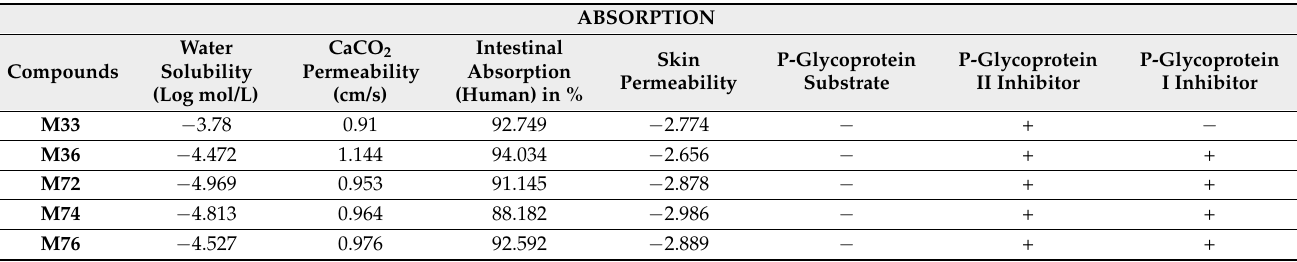
Table 3. Various absorption parameters of the proposed pyrazole